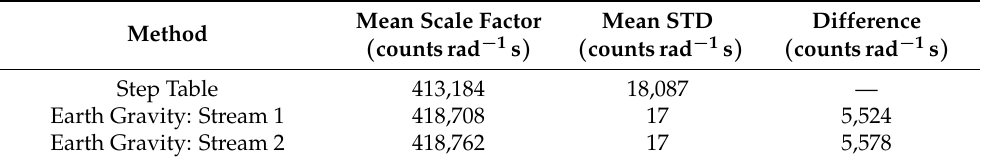
Table 5. The mean scale factors and the standard deviations of the scale factors for sensor number 0083 computed from step table input and from comparison with gravitational acceleration from two quiet streams of data: Stream 1: 27 November to 29 November and Stream 2: 29 November